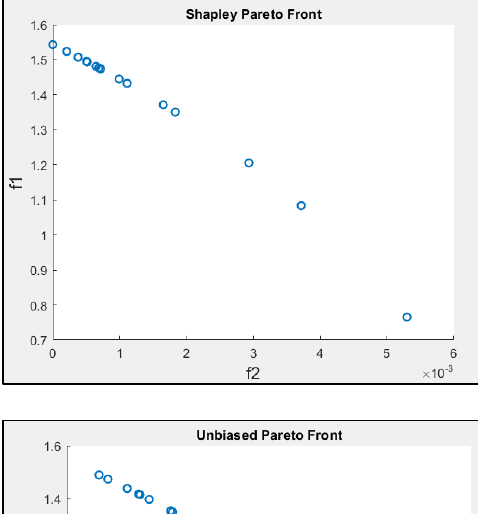
Figure 6. Pareto front of the multi-objective algorithms for energy efficiency and sensing duration Figure 6. optimization.